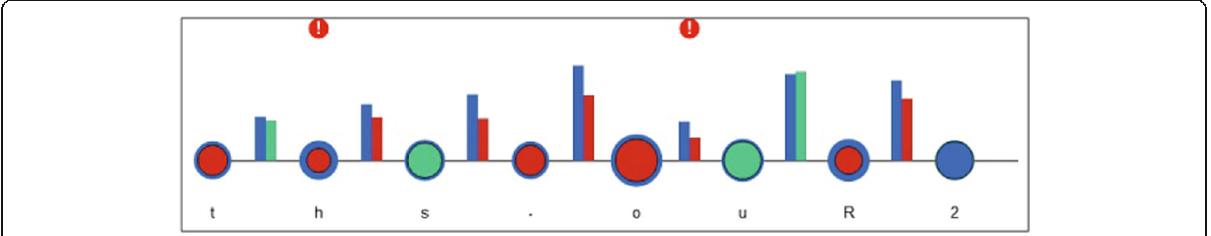
Fig. 8 The interface of the imitation system (Meng et al. 2013)